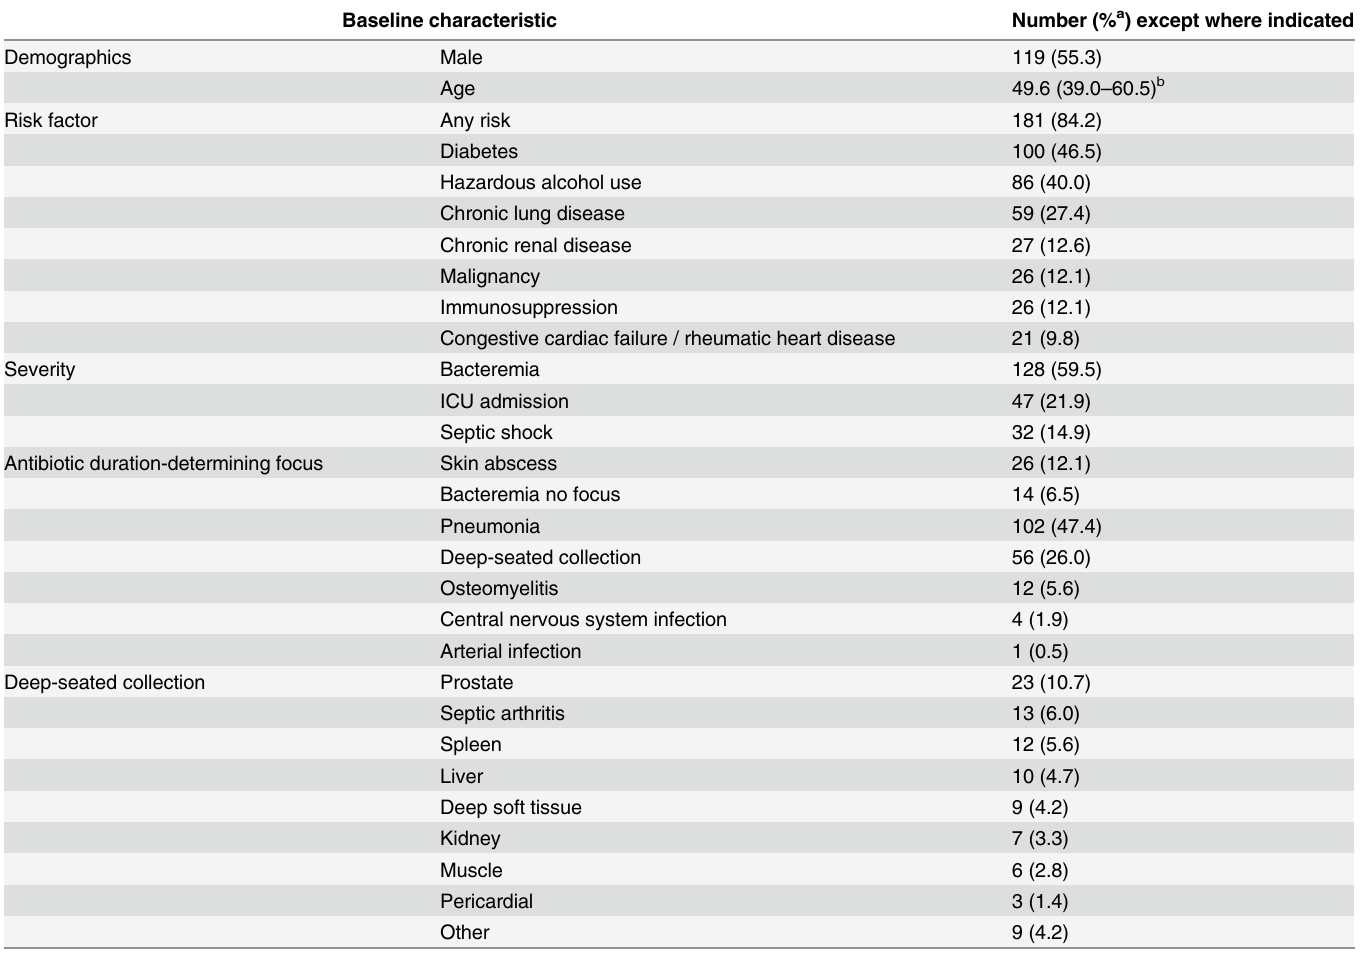
Table 2. Baseline